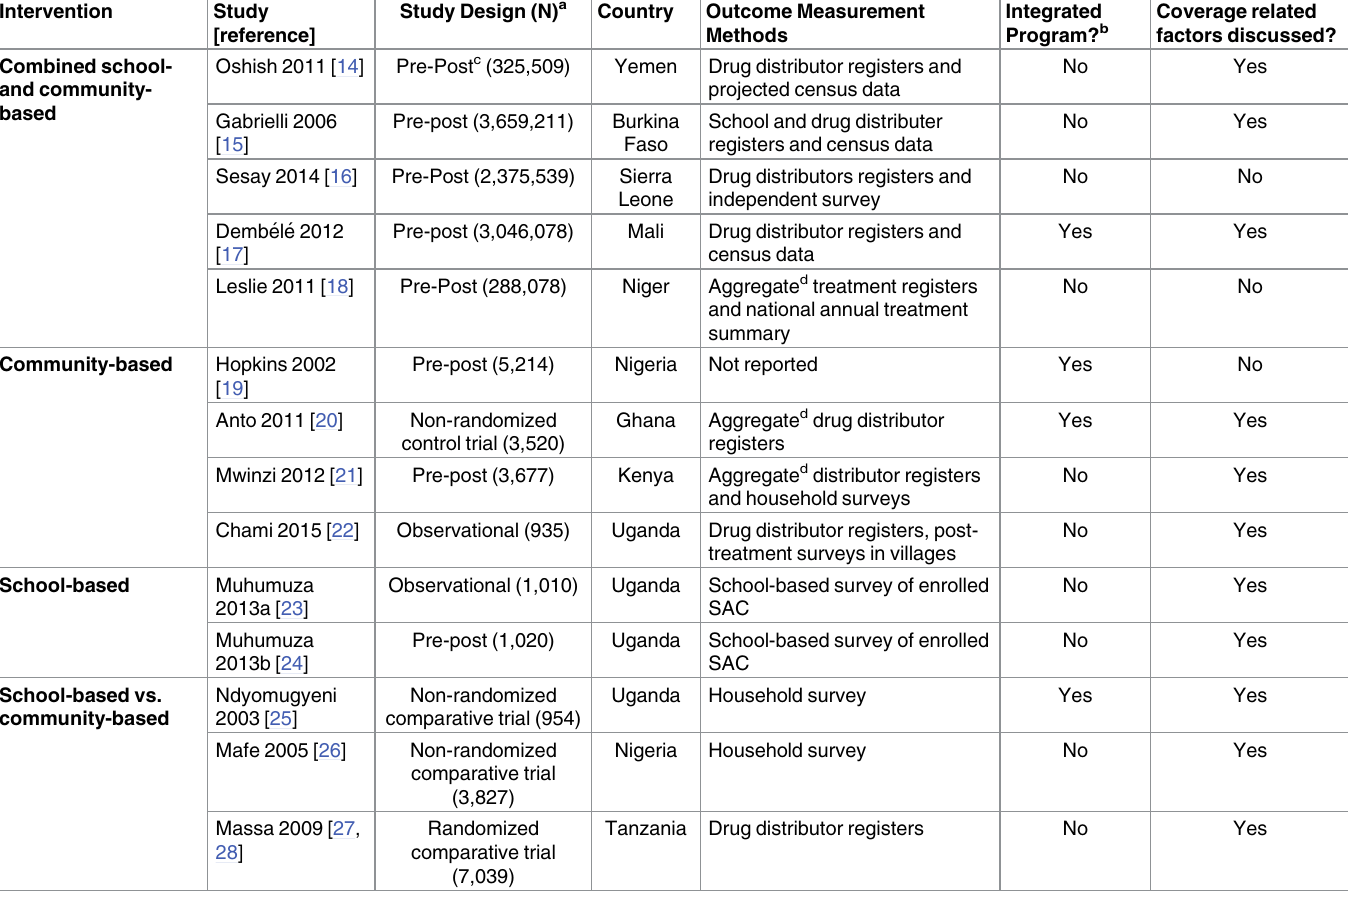
Table 1. Included studies with quantitative data on MDA